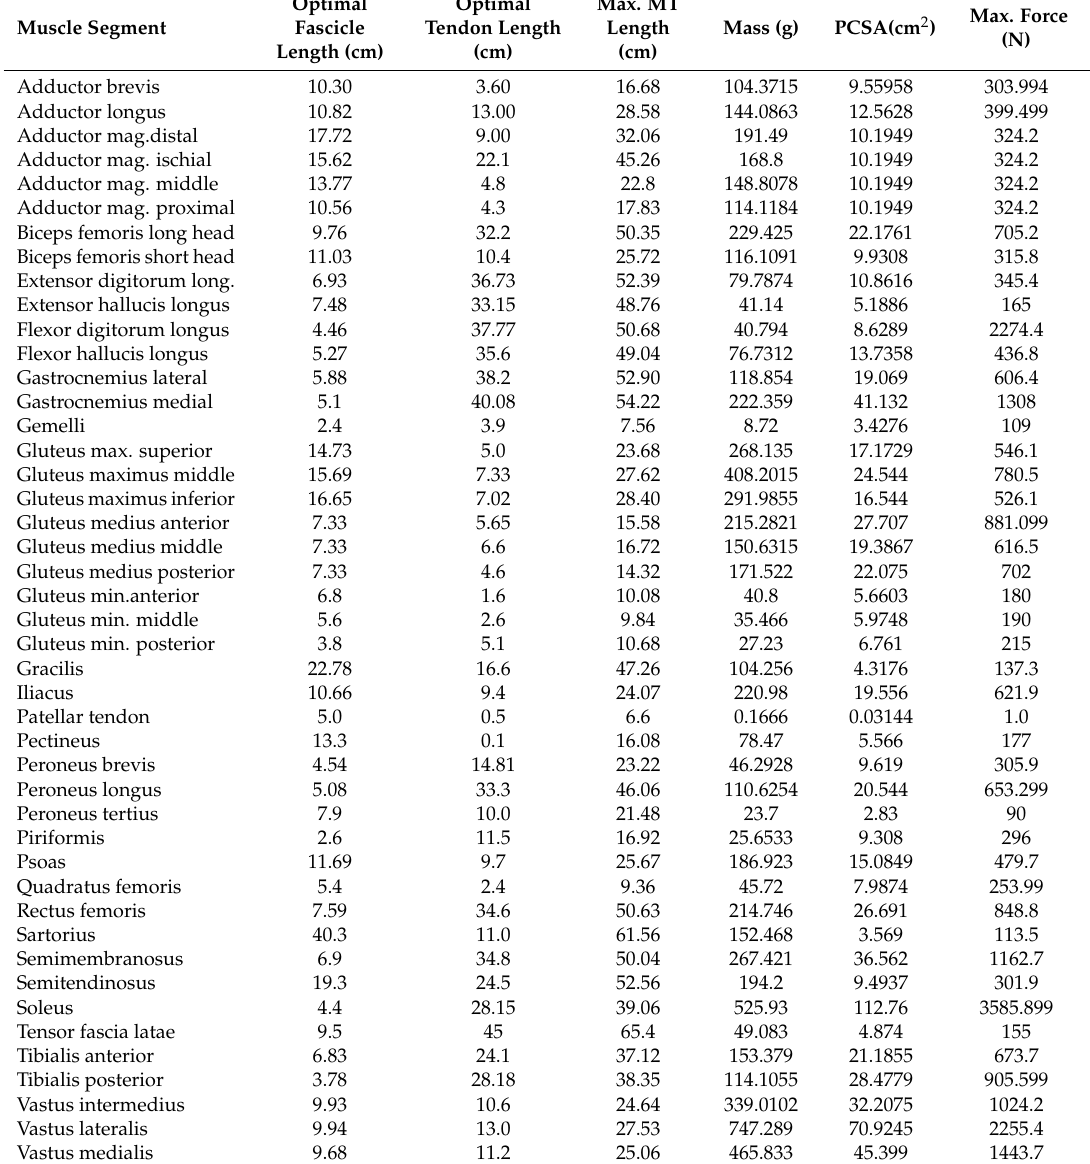
Table 2. Morphometrics values of the model